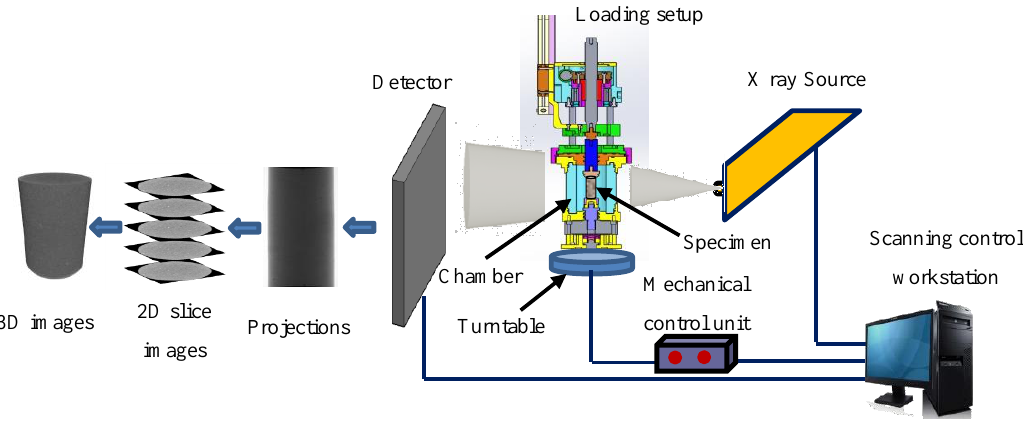
Figure 2. Schematic of the X-ray microtomography system and the in situ loading setup .